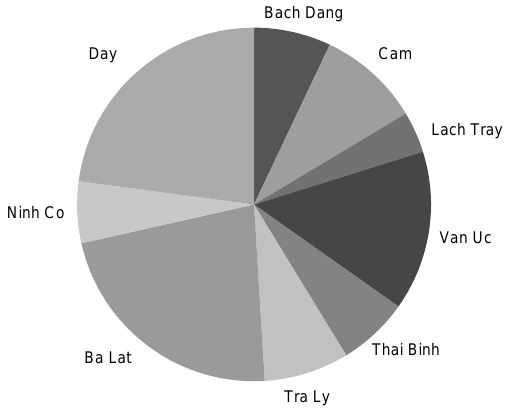
Figure 6. Distribution of water discharge amongst the nine distribu- taries of the Red River after the Hoa Binh dam impoundment.